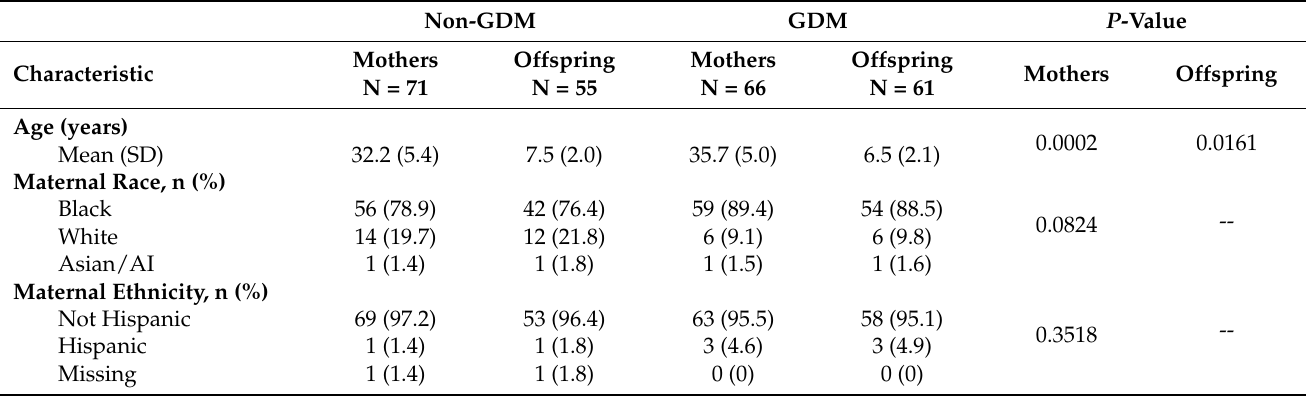
Table 1. Participant Demographics for Mothers and Children from the HAPI Study (N =